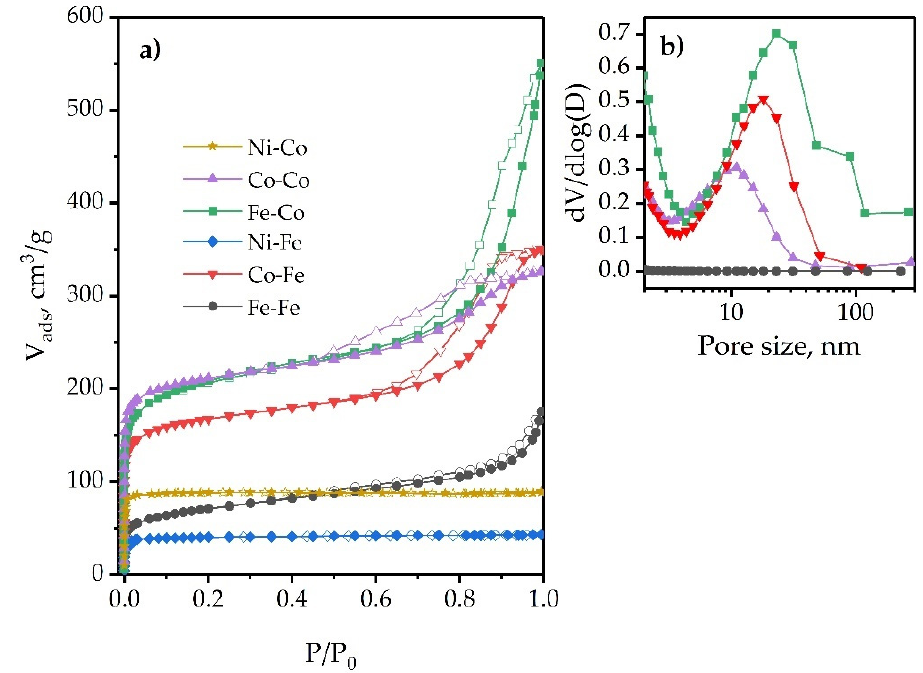
Figure 8. Textural properties of the studied porous hexacyanometallates(II): ( a ) N 2 adsorption- desoprtion isotherms, ( b ) BHJ mesopore size distribution obtained from the adsorption branch. Table 6. Comparison of total surface area (S BET ), external surface (S ext ) area, and micropore surface area of hexacyanometallates(III) based on N 2 adsorption data.